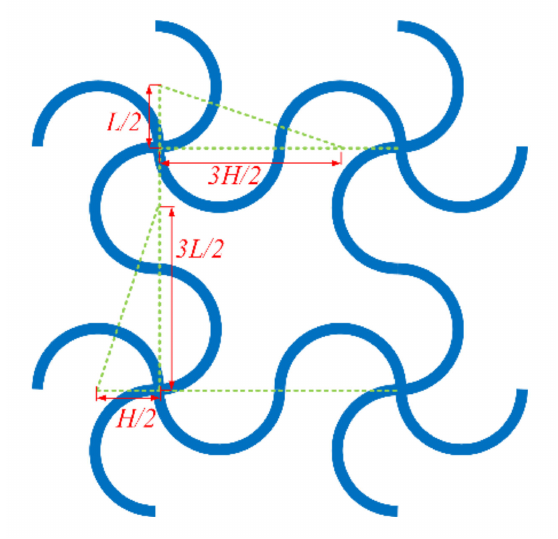
Figure 2. Overlapping